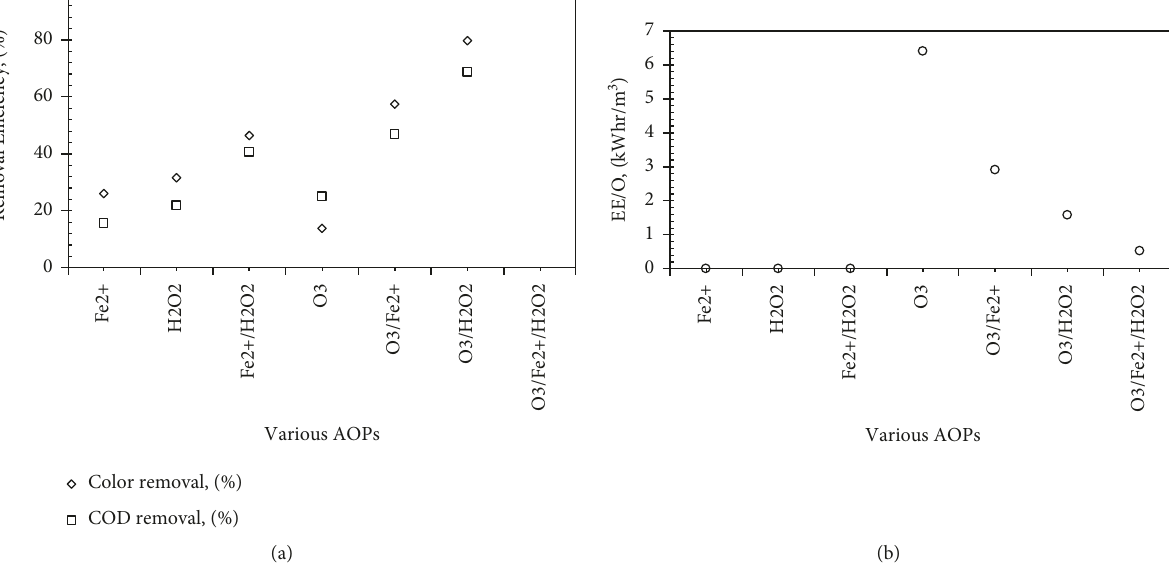
2+ /H 2+ , O 2+ /H 2 O 2 , Fe 2 O 2 , O 3 , O 3 /Fe 3 /H 2 O 3 , and O 3 /Fe 2 O 2 on (a) % color and %